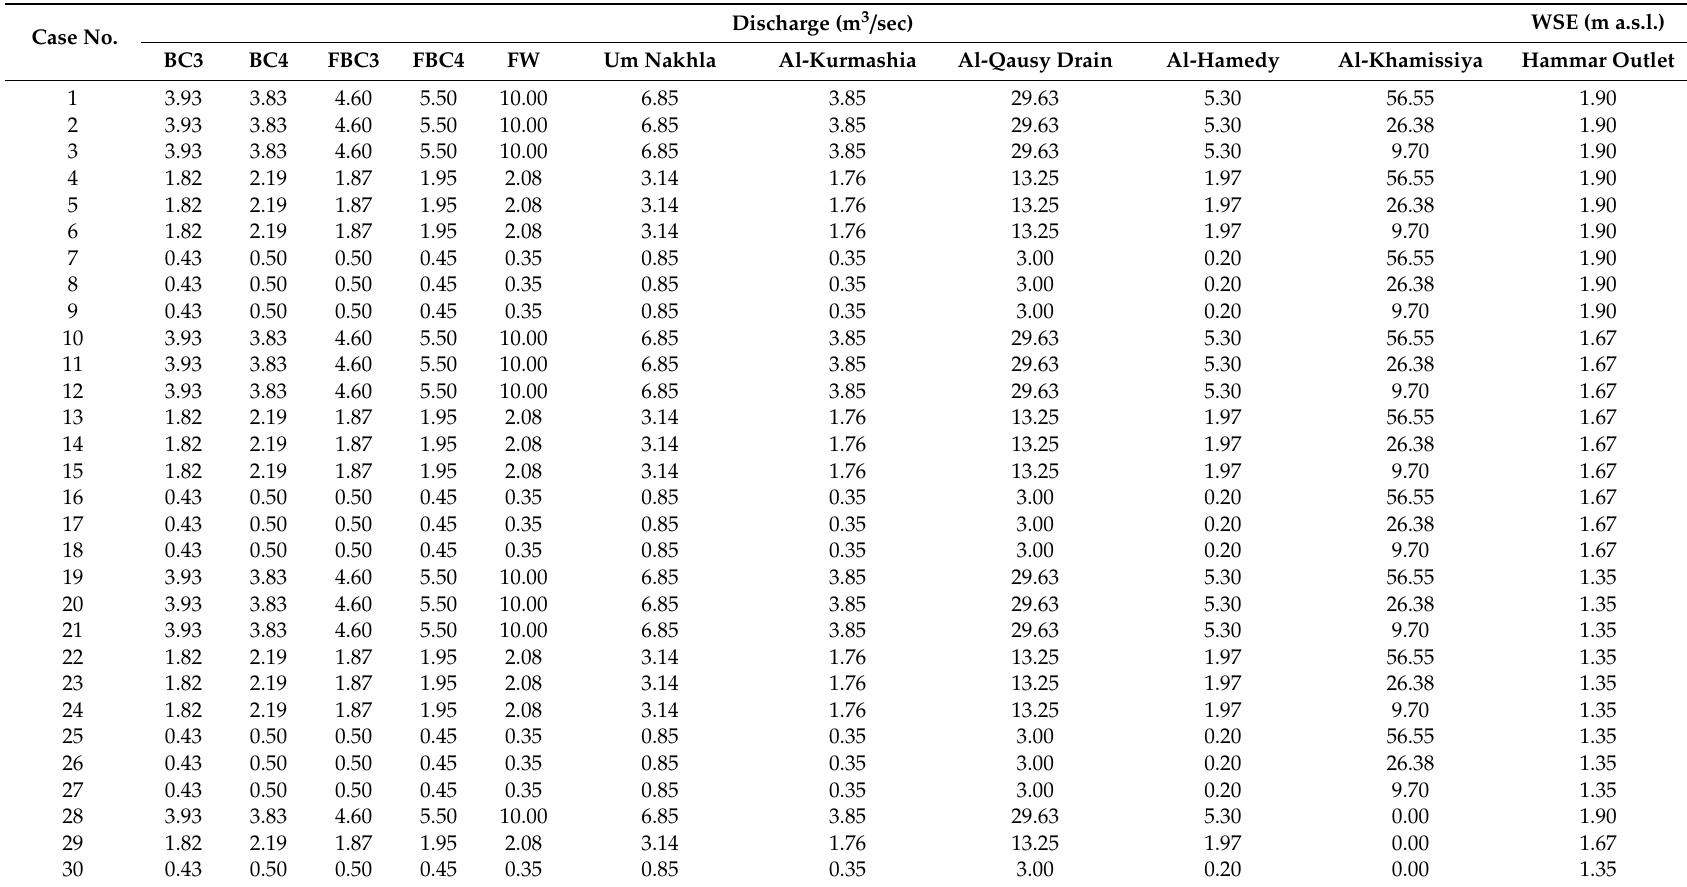
Table 2. Potential cases of marsh boundary conditions for the hydrodynamic simulation model (CRIMW 2017 (unpublished data)). Case